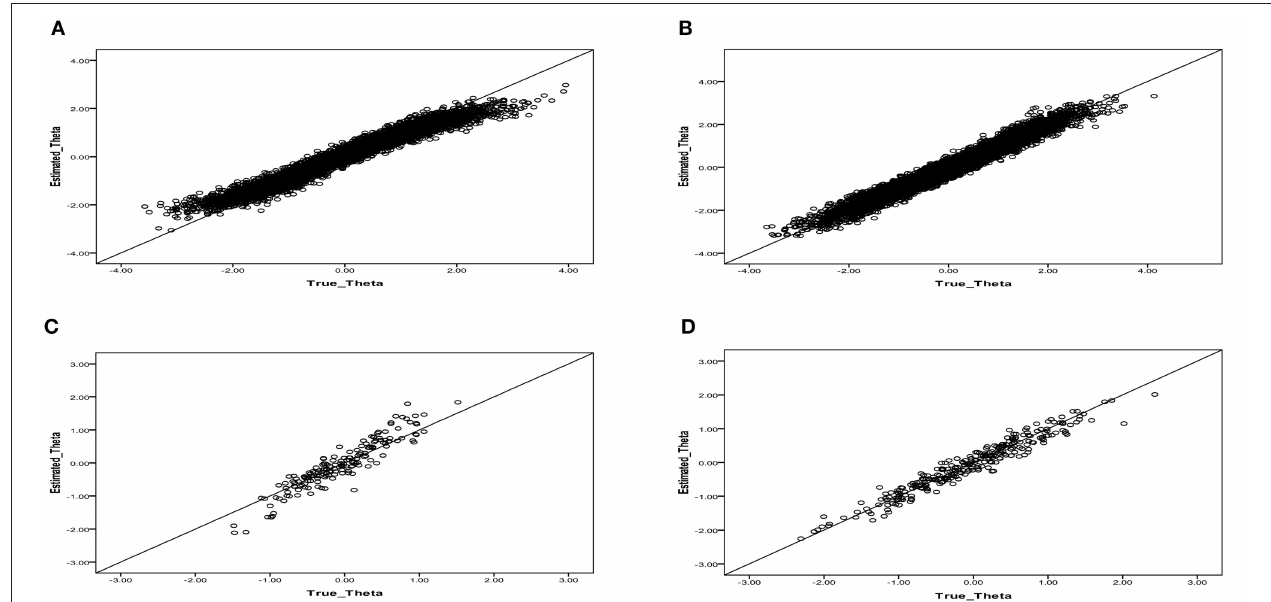
FIGURE 1 | Relationship between the true and estimated latent trait parameters when respondents were misclassified by using the single-class ERS-GPCM to fit the mixture ERS-GPCM data. (A) Individuals in the MRS class that were misclassified into the normal class. (B) Individuals in the ERS class that were misclassified into the normal class. (C) Individuals in the normal class that were misclassified into the MRS class. (D) Individuals in the normal class that were misclassified into the ERS